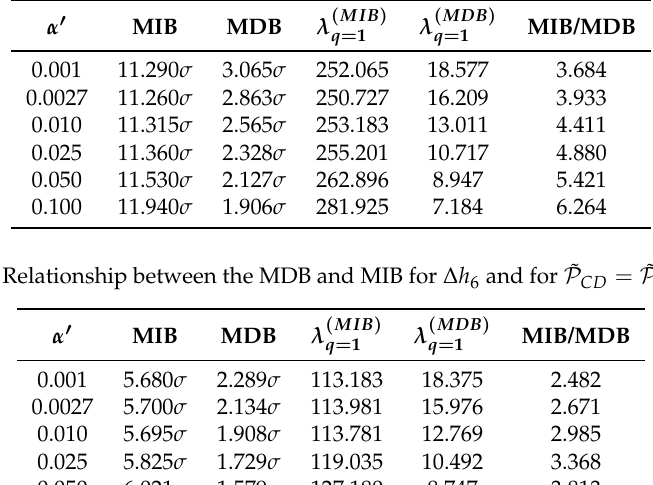
Table 10. Relationship between the MDB and MIB for ∆ h 5 and for ˜ P CD = ˜ P CI = 80%.